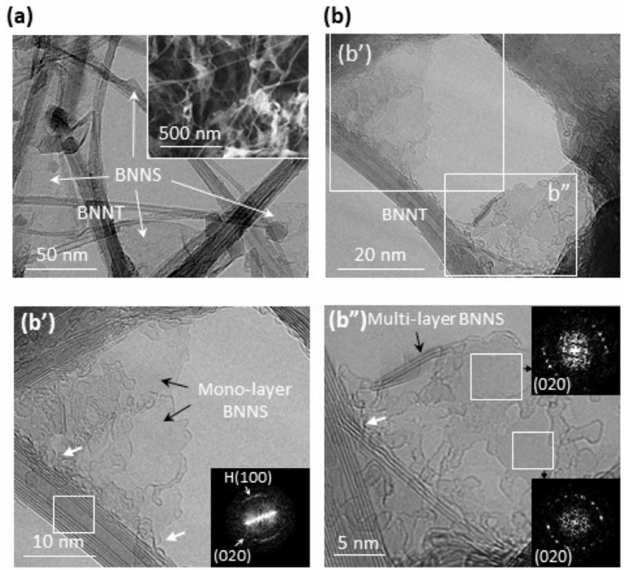
Figure 4 HRTEM images of BNNTs. ( a ) A low-magnification TEM image of the BNNT sample. The inset shows an SEM image revealing the typical fluffy cotton-like morphology of BNNTs. ( b ) An HRTEM image revealing the typical fluffy cotton-like morphology of BNNTs with coexisting mono- layer and multi-layer BNNSs. ( b 0 ), ( b 00 ) Magnified images in the squares in ( b ). The inset in ( b 0 ) shows the FFT pattern obtained from the square on the left BNNT, revealing evidence for the zigzag AA h BN helix. The multi-layer BNNS ( b 00 ) reveals the unique eye-like FFT patterns for AA h BN